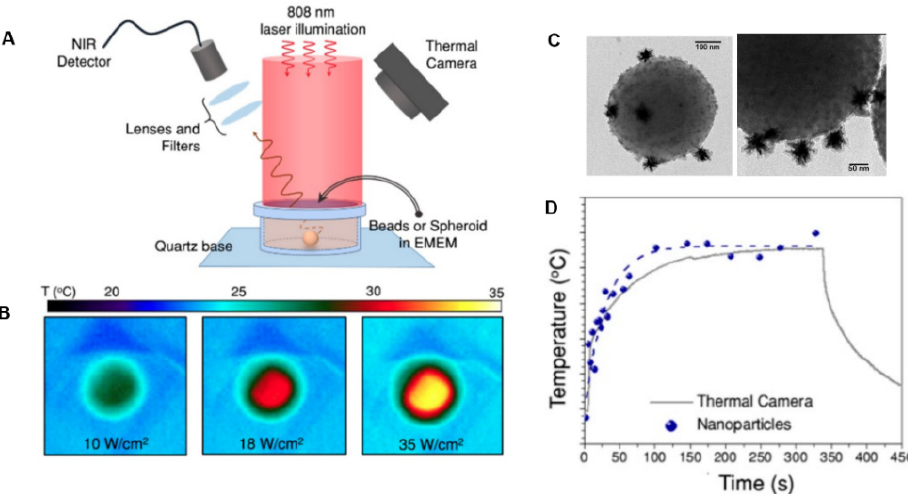
Figure 12. Heating and emitting properties of hybrid beads containing gold nanostars and CaF2:Nd3+, Y3+ nanoparticles. ( A ) Experimental set-up used to illuminate the samples and record their luminescence while monitoring the temperature of the solution with a thermal camera. ( B ) Thermal camera images upon illumination of 1 mL of bead solution with three different powers. ( C ) TEM images of hybrid nanoprobe including bead, gold nanostars, and CaF2:Nd3+, Y3+ nanoparticles. ( D ) Temperature curve of the dispersion of beads over time, illuminated at 2400 mW, measured using a thermal camera (grey squares) and nanothermometry (blue dots). Adapted with permission from